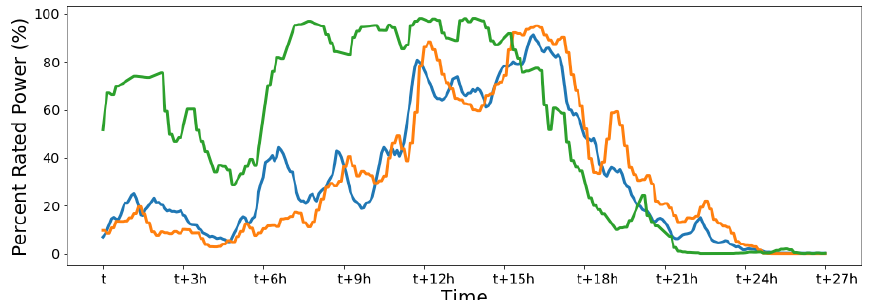
Figure 13. Time series of total power output of the wind farm used in this study (green) and two other wind farms in the area (orange and blue). The values on the x axis show time at 3h